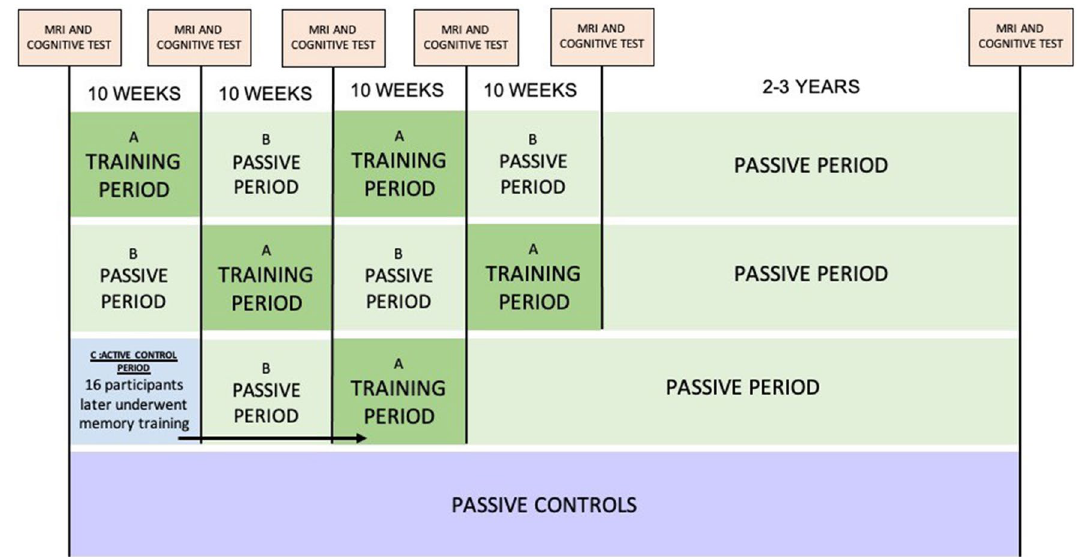
Figure 1. Design. Memory-training groups: the memory trainers were allocated to either an ABAB (top row) condition or a BABA (second row) condition. The training intervention was equal for both conditions. Active control group (third row); after participating in the active control group, participants were offered to undergo a 10 weeks passive period followed by a training period, resulting in a CBA design. 16 participants (4 young, 12 older) proceeded to train. Passive control group (bottom row); a long-term passive control group was tested and scanned at two time points with no intervention, with a similar interval between baseline and follow-up as the rest of